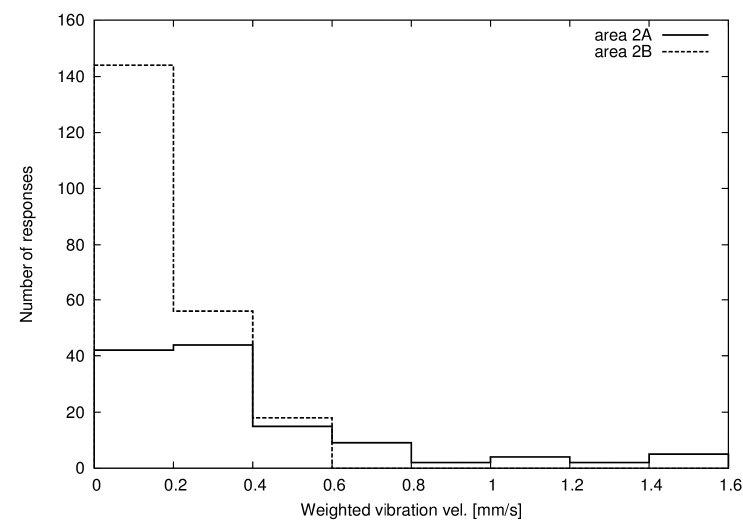
Figure 2. Histogram of number of responses in 0.2 mm/s intervals of weighted maximum vibration velocity for areas 2A and 2B (noise and vibration).